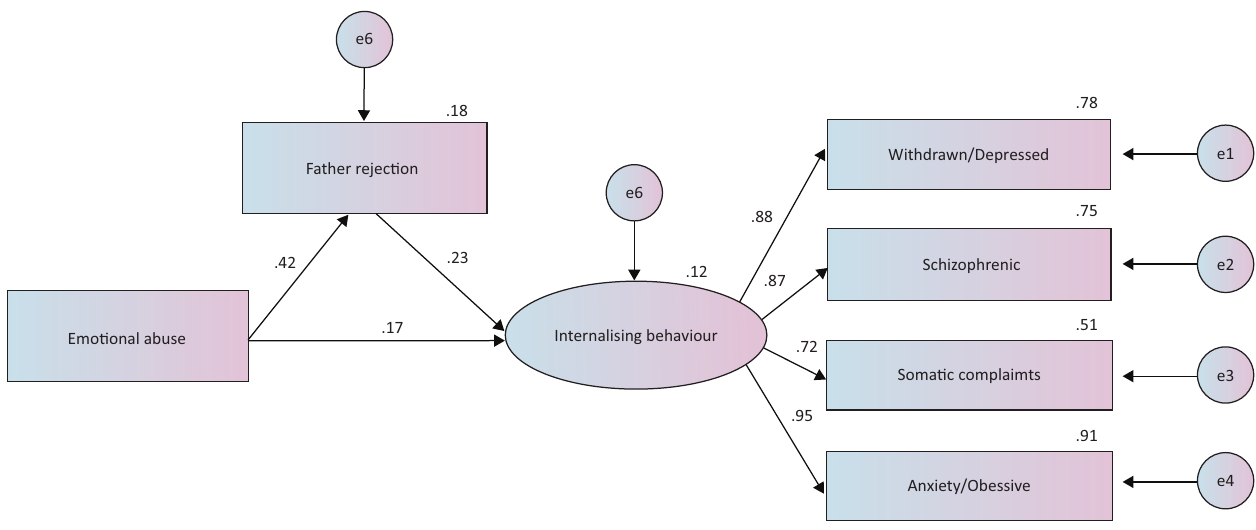
FIGURE 3: The partial mediation model in female sample ( n =